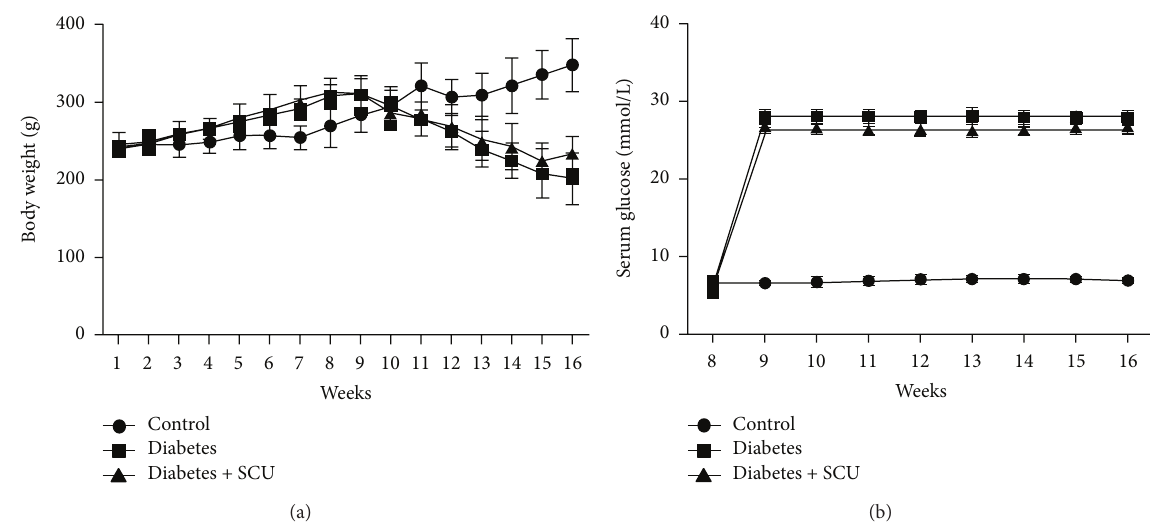
Figure 1: Body weights and serum glucose concentrations. STZ were administrated into diabetes group and diabetes + SCU group at week 8. One week later, diabetes + SCU group was daily administrated with SCU from week 9 to week 16. (a) Body weight and (b) glucose concentration were measured as described in methods.